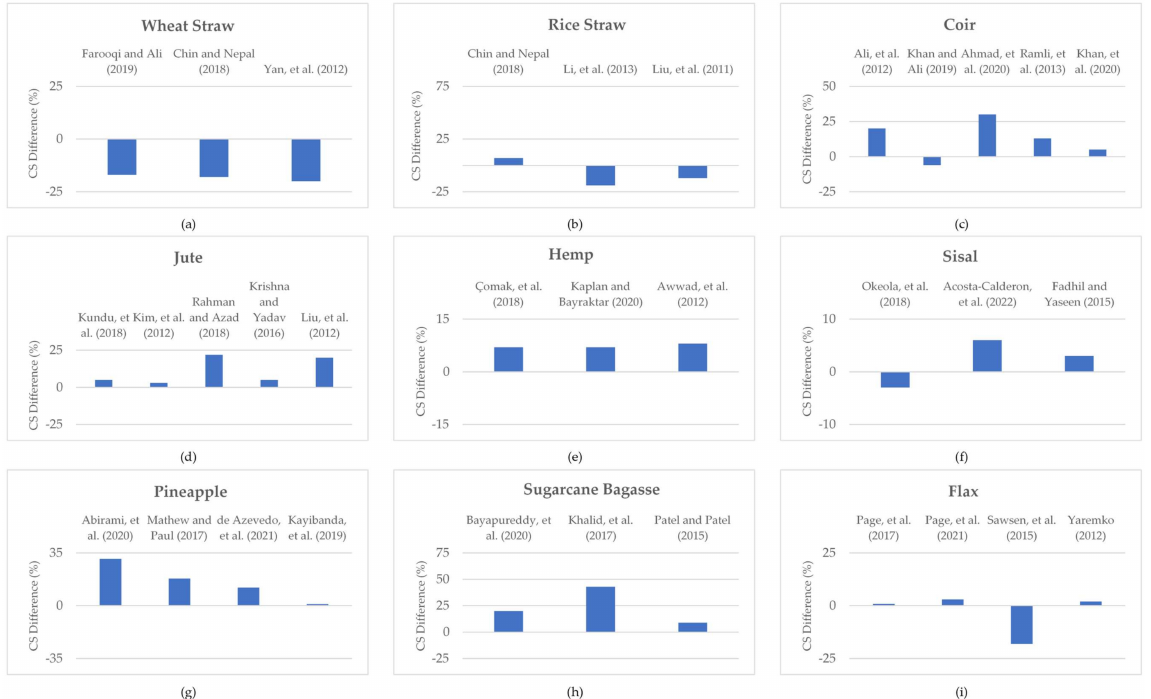
Figure 18. Percentage difference in compressive strengths of ( a ) Wheat straw, ( b ) Rice straw, ( c ) Coir, ( d ) Jute, ( e ) Hemp, ( f ) Sisal, ( g ) Pineapple, ( h ) Sugarcane Bagasse, and ( i ) Flax fiber re- inforced cementitious composites with respective reference composites.